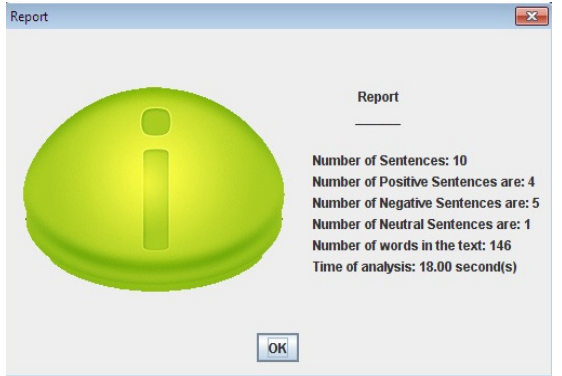
FIG. 3: DESCRIPTIVE STATISTICS FOR THE INPUT PROVIDED